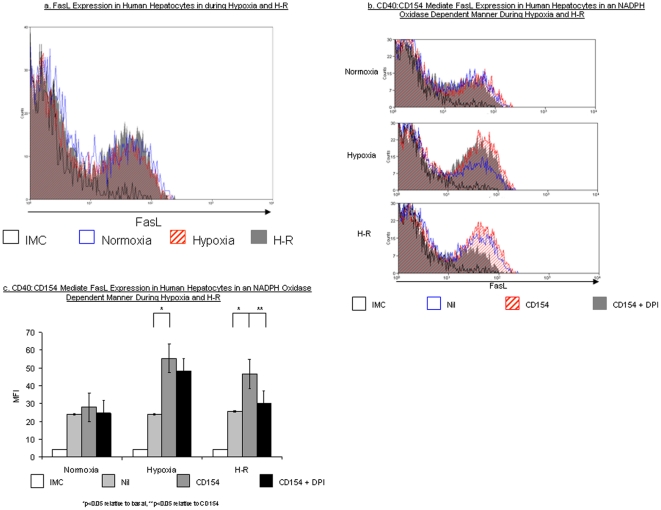
FasL Expression on Primary Human Hepatocytes.
Figure 4a demonstrates a representative flow cytometry plot of FasL expression on primary human hepatocytes during normoxia, hypoxia and H-R. The gate used to analyse primary human hepatocytes is the same as that shown in Figures 1 & 2. Figure 4b. demonstrates representative flow cytometry plots to illustrate the effect of CD154 (hatched red) and CD154 in presence of DPI (solid grey) upon human hepatocyte FasL expression during normoxia, hypoxia and H-R. Figure 4c. shows a bar chart with the pooled data of three separate experiments illustrating the effects of CD154 upon human hepatocyte FasL expression during normoxia, hypoxia and H-R. Data are expressed as MFI and readings are based upon values taken from cells within the gated region in Figure 1a. Data are expressed as mean ± S.E. (*p<0.05 relative to basal, **p<0.05 relative to CD154).